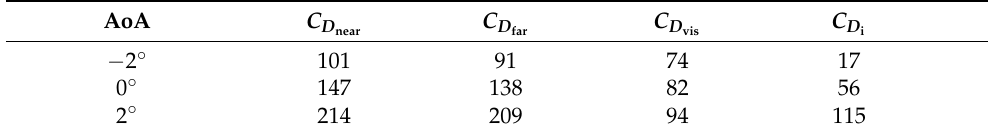
Table 7. OFF configuration (fine mesh level) at Re ∞ = 16.6 × 10 6 , M ∞ = 0.480. Breakdown of the drag polars without spurious drag detection; induced drag computed by Maskell’s formula.